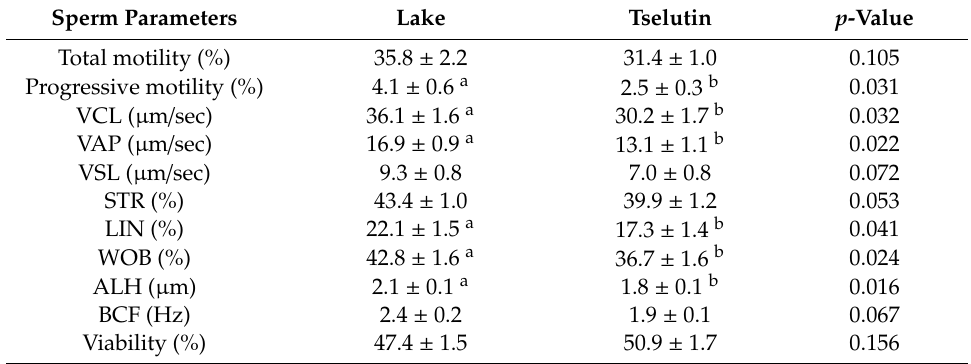
Table 4. Probability of t -test and means ± SEM of sperm quality parameters recorded in thawed turkey semen samples (n = 6) frozen in the presence of Lake and Tselutin extender. Sperm Parameters Lake Tselutin p -Value Total motility (%) 35.8 ± 2.2